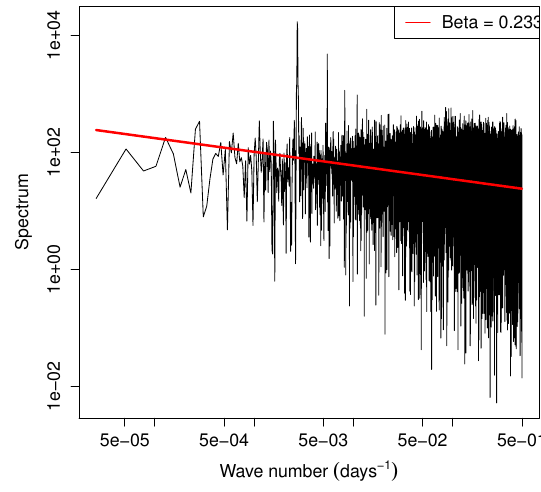
Fig. 2. Simple power spectrum (no windowing used) of Brandon daily snowfalls. The best-fit line corresponds to Eq. (1), for wave- lengths greater than